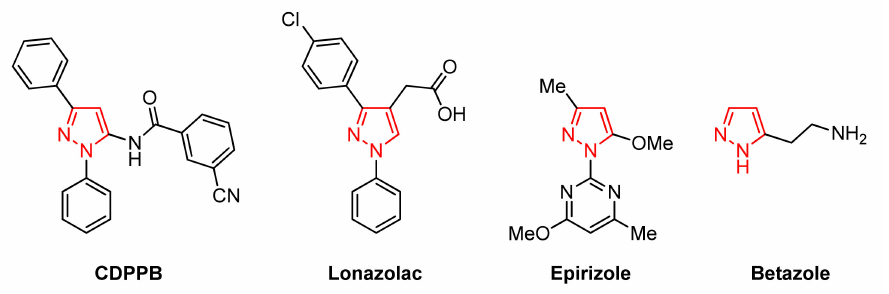
Figure 1. Marketed drugs containing pyrazole